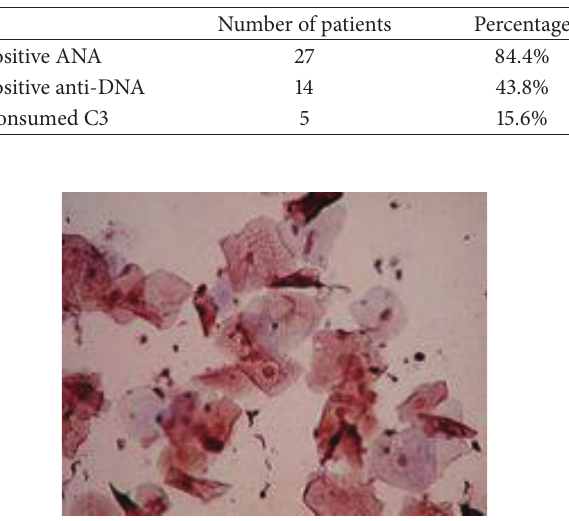
Figure 4: A case with HPV type 16 infected cells showing koilocytic changes (CIN I) ( ×